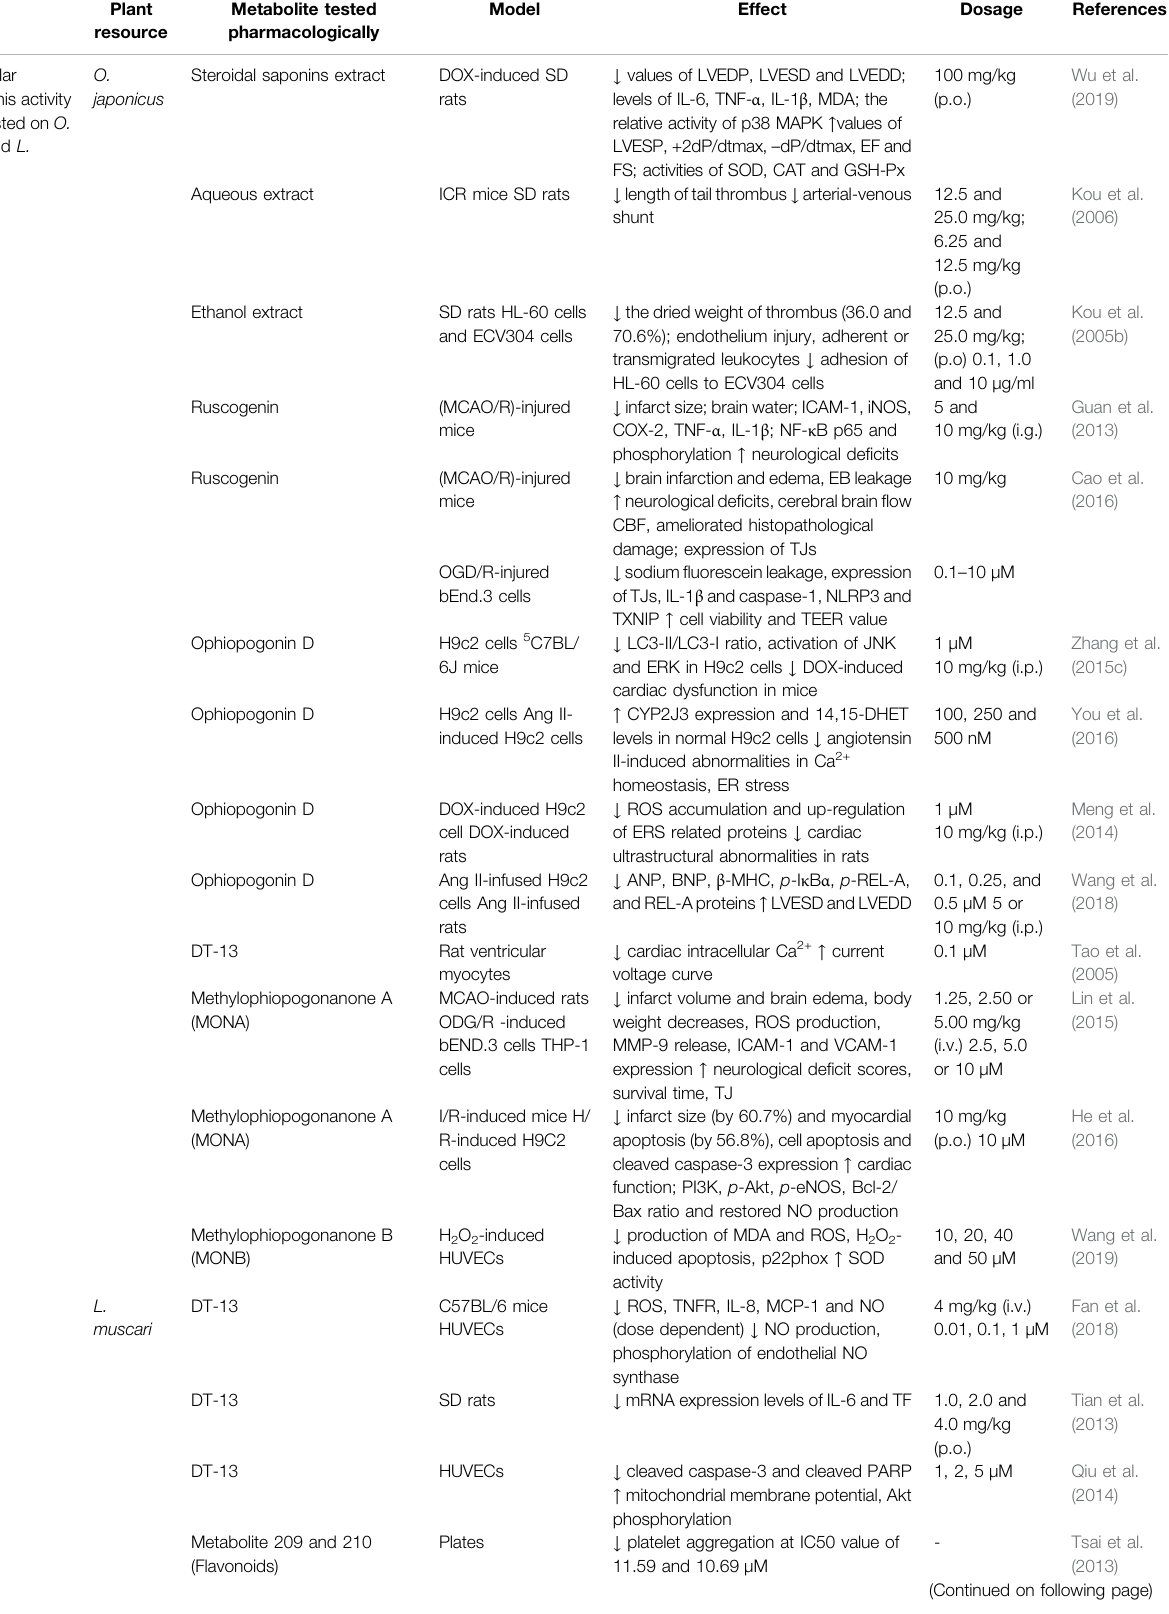
TABLE 3 | Summary of pharmacological studies on extracts/metabolites isolated from liriopogons included in this review.